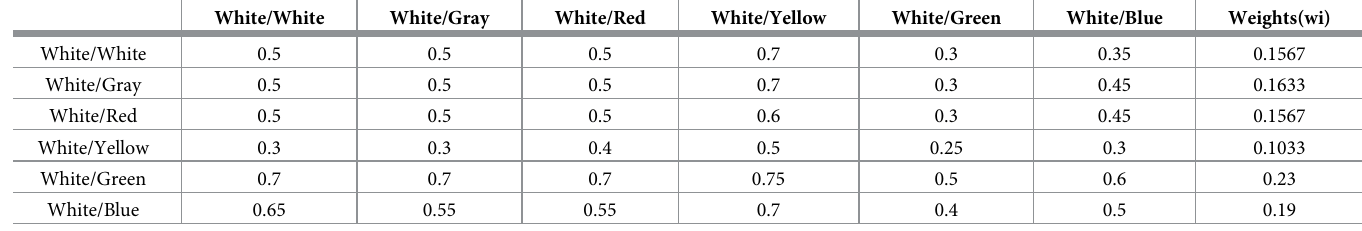
Table 6. FAHP analysis table.